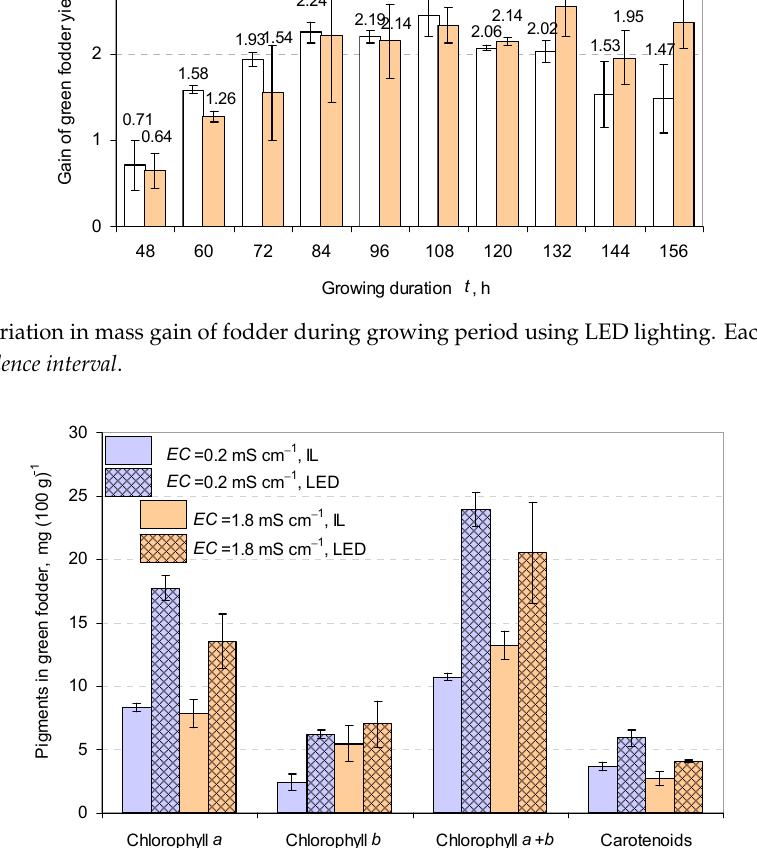
Figure 10. Pigment content in green fodder after seven days of cultivation depending on lighting (indoor lighting or LED) and nutrient solution (electrical conductivity (EC)). Each vertical bar is 95% confidence interval. Table 2. Cost (EUR with value added tax (VAT)) of 1000 kg hydroponic feed (14.7% dry